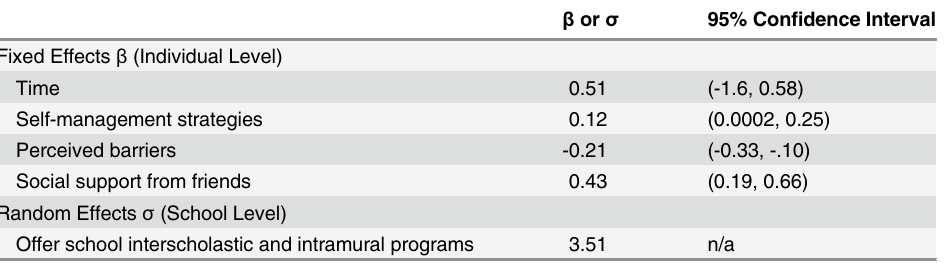
Table 3. Regression Coefficient and Variance Estimates for Longitudinal Physical Activity using the Selected Fixed and Random Effects